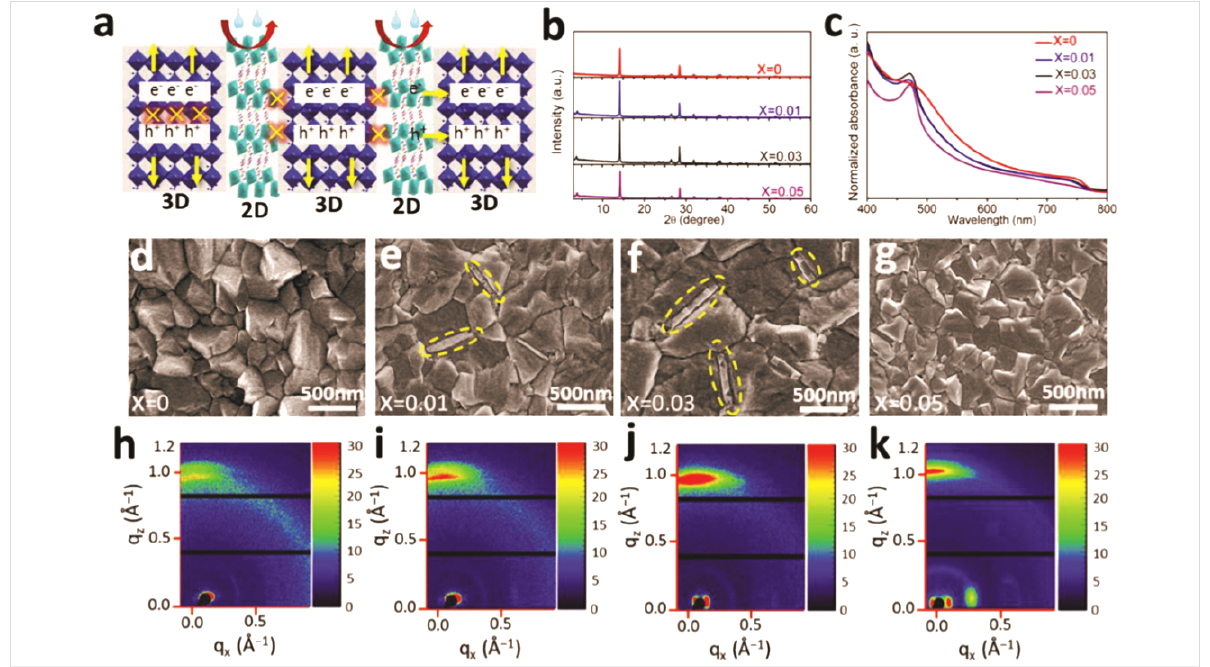
Figure 4: Structural characterization and morphology. (a) Schematic illustration of the structure of the 2D/3D PSCs. (b) XRD patterns as a function of the 2D perovskite doping concentration and (c) UV–vis absorption spectra of the (EDBEPbI 4 ) x (MAPbI 3 ) 1 − x films. (d–g) SEM images of perovskite films with different 2D concentrations. The “flake-like” structure in the yellow area is EDBEPbI 4 . (h–k) Grazing-incidence wide-angle X-ray scattering (GIWAXS) images of the films with different 2D concentrations. Reflections at q z ≈ 1 is assigned to 3D perovskite (110). Reproduced with permission from [62], copyright 2018 John Wiley and